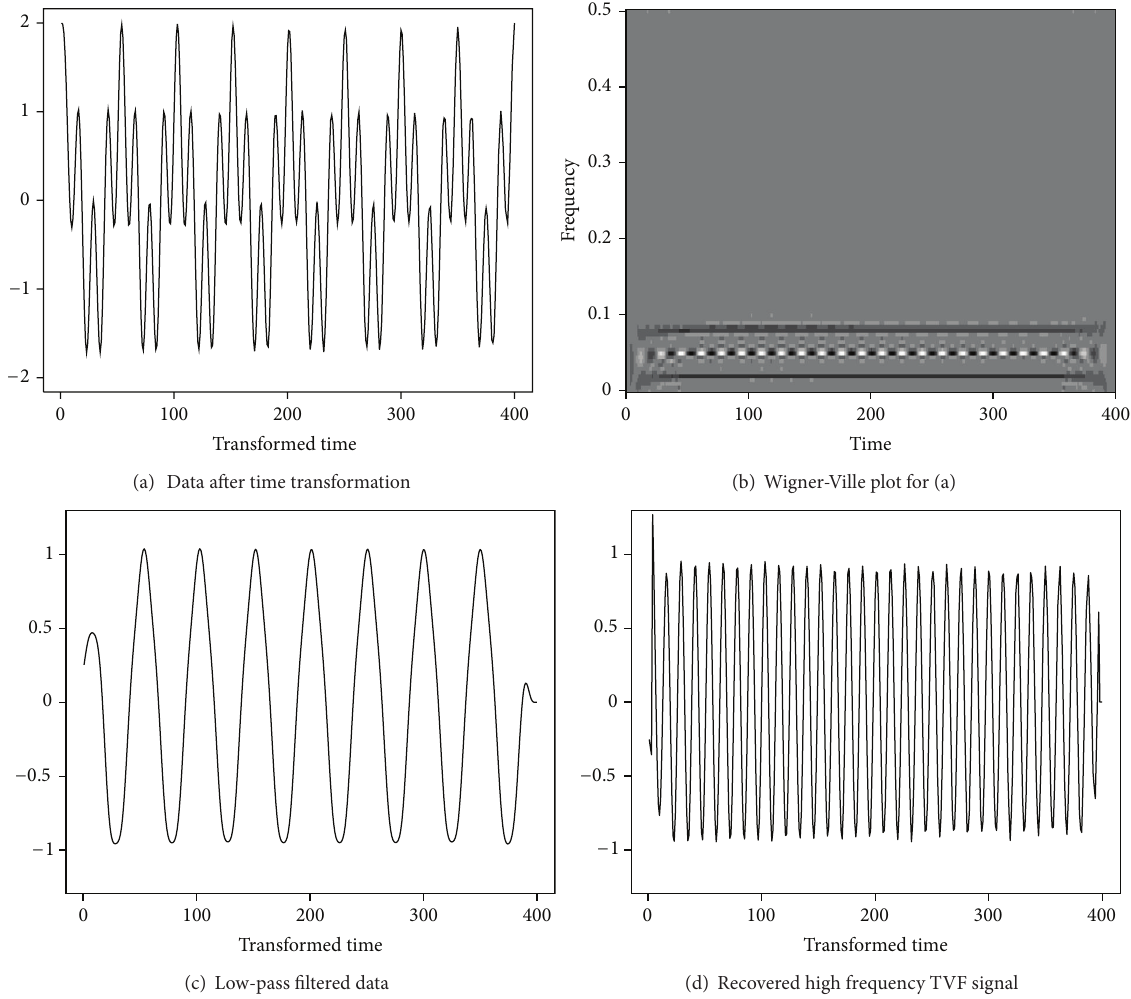
Figure 2: (a) The dual data obtained from Figure 1(a) using GWS software; (b) Wigner-Ville time-frequency plot for (a); (c) recovered low frequency component from (a); (d) recovered high frequency component from (a).